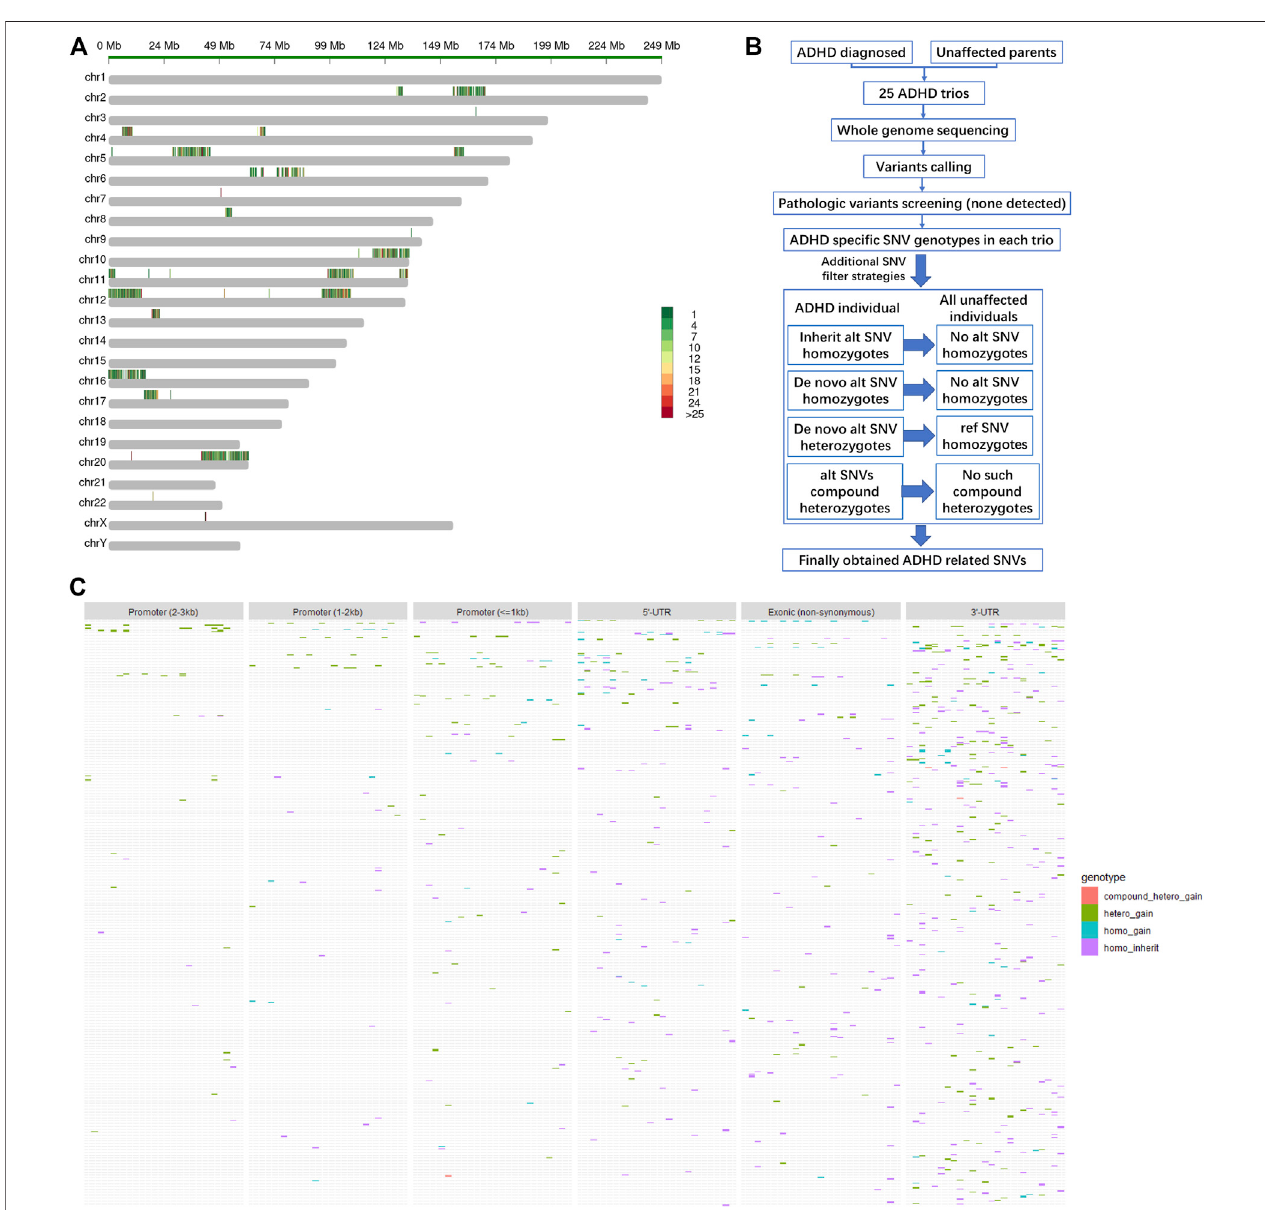
FIGURE 1 | Distribution of fi ltered SNVs in the reported ADHD-susceptible regions. (A) A map showing the reported ADHD-susceptible regions in the human genome and the distribution of the variations in these regions in the cohort. Color annotation: red to green, high to low frequency detected in the cohort. (B) A diagram depicting the strategies for SNV fi ltering in the cohort. (C) Heatmaps showing the distribution of fi ltered SNVs in ADHD children as well as in genomic regions including promoters, 5 ′ -UTR, coding region (exon), and 3 ′ -UTR. Genotype categories of each site were labeled in different colors as indicated in the legend.